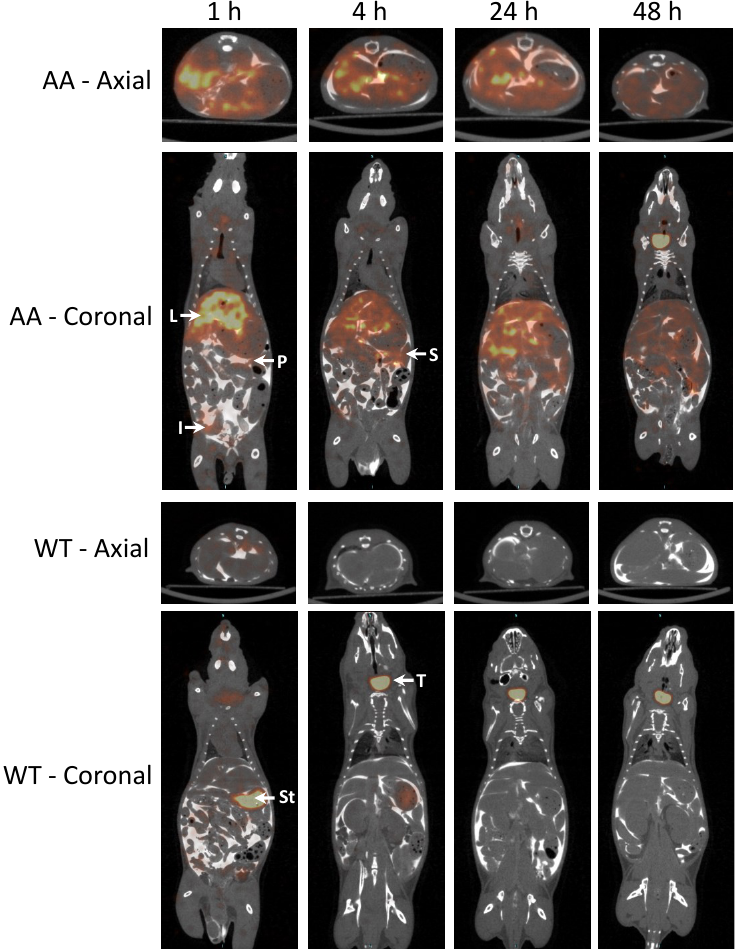
Figure 3. SPECT imaging of 125 I-p5+14 revealed preferential uptake of peptide in amyloid-laden organs in AA mice, but not wild type (WT) animals. SPECT/CT images of mice ( n = 3 per time point) injected with 125 I-p5+14 were acquired at 1, 4, 24 and 48 h post-injection. Peptide was observed in the liver (L), spleen (S), pancreas (P) and intestines (I) of AA mice in axial and coronal views at all time points. In contrast, in WT mice, only free radioiodide liberated during catabolism was seen transiently in the stomach (St) and over the course of the investigation in the thyroid (T). Mice received, IP, ~300 µL of Iohexol CT contrast agent (1:1 in sterile PBS) 5 min prior to imaging to delineate abdominal organ